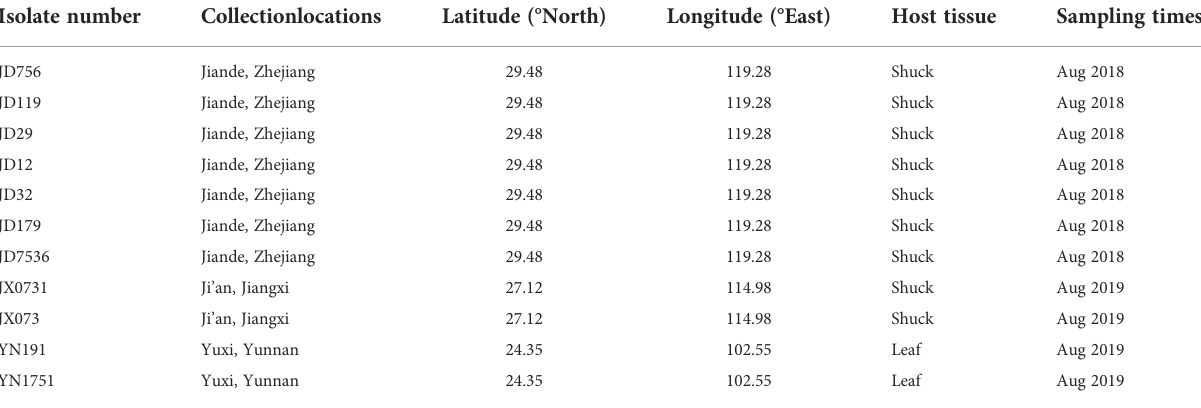
TABLE 1 A list of Colletotrichum isolates collected from pecan based on preliminary identi fi cation. Isolate number